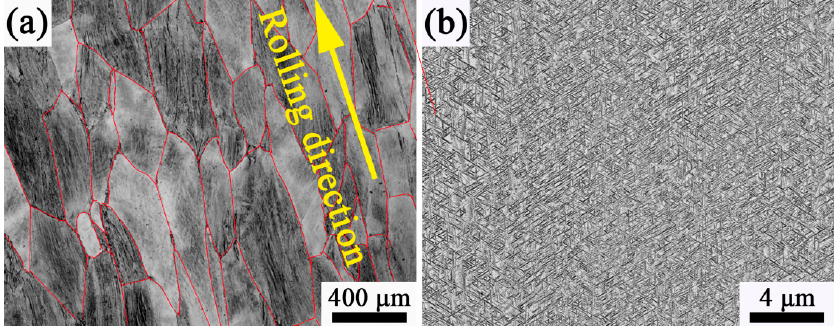
Figure 1. Microstructure of the as-rolled specimen: ( a ) Optical micrograph; ( b ) Scanning Electron micrograph.